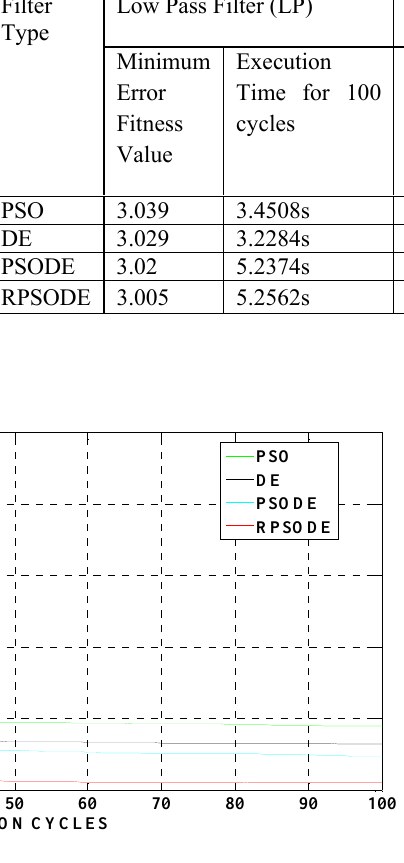
Figure 4. Comparison of convergence profiles for PSO, DE, PSODE and RPSODE of LP filter of order 20.